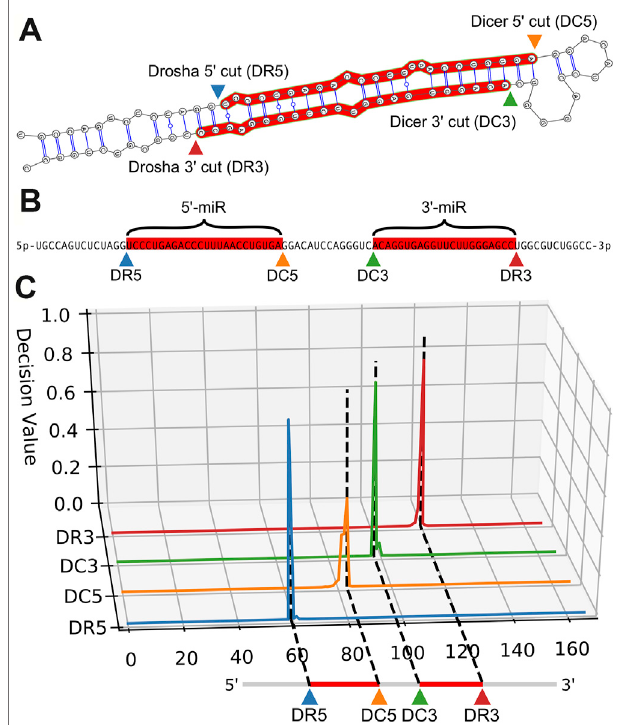
FIGURE 2 | Example cleavage site identi fi cation for hsa-mir-125a. (A) . Dicer and Drosha cut sites relative to the secondary folding structure of hsa- mir-125a. The enzymes Dicer and Drosha cleave the hairpin resulting in the two mature microRNA sequences highlighted in red. (B) . A linear representation of the same RNA sequence, with the mature products highlighted in red, and labels indicating cut sites and mature products. (C) . Quantitative curves show the predictions of DeepMirCut along the length of the extended precursor sequence for the Drosha and Dicer 5 ′ and 3 ′